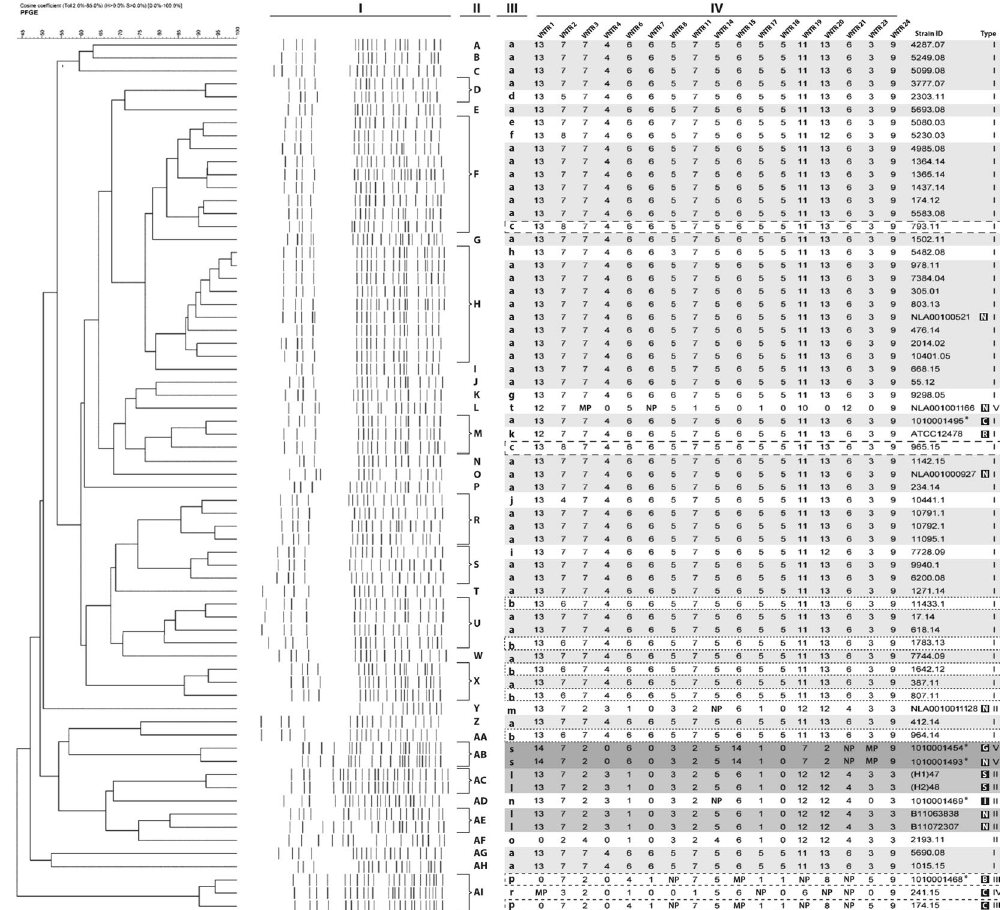
Figure 2. PFGE and VNTR analysis of analyzed isolates. A dendrogram constructed for 67 M. kansasii isolates, based on the joint results of 17-loci VNTR and PFGE profiling. I– PFGE banding patterns; II, III– Designation of PFGE (II) and VNTR profiles; IV– TR copy number at each of the 17 loci (VNTR code); VNTR codes highlighted with an identical shade of grey or boxed by dashed lines of different dash spacing correspond to different VNTR clusters; * Strains of environmental origin; Letters in black squares refer to country of strain isolation; N– the Netherlands; C– the Czech Republic; R– reference strain; G– Germany; S– Spain; I– Italy; B– Belgium; NP, no PCR product; MP, multiple-band profile. Due to large number of analysed isolates, the samples were derived from multiple experiments. The gels were processed using BioNumerics ver. 5.0 software (Applied Maths, Sint-Martens-Latem, Belgium) software in